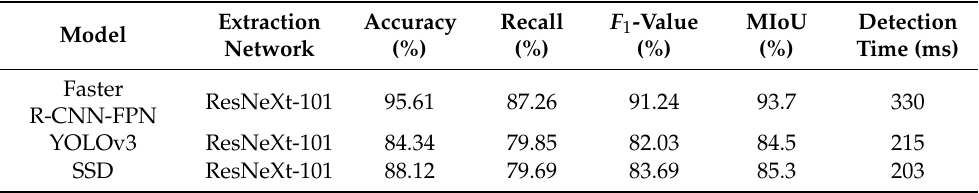
Figure 12. Comparison of the precision of the Faster R-CNN and SSD models. Table 3. Deep network model comparison.